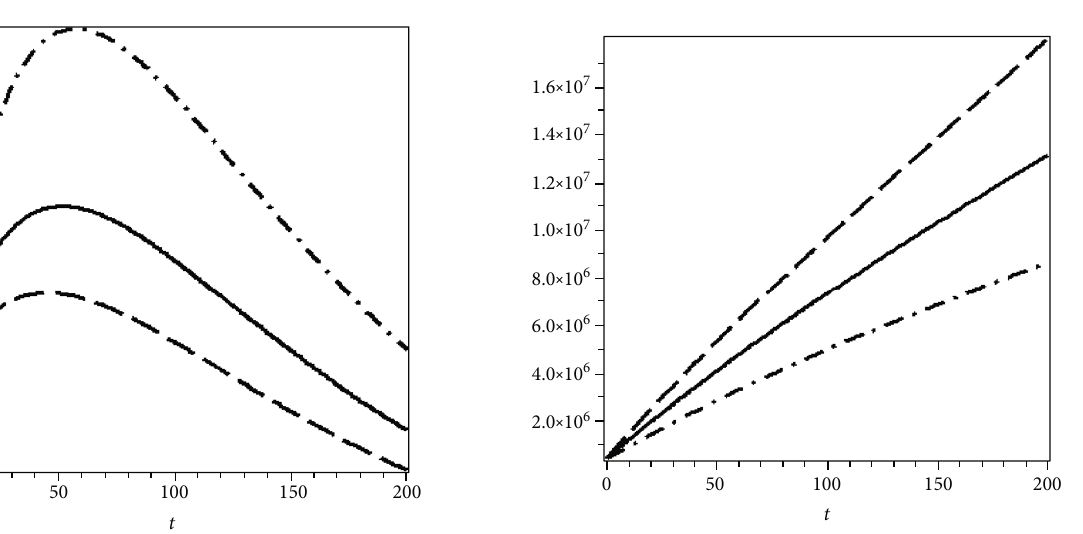
Figure 10: The e ff ect of the reproducing number on the infected individuals (dashed line, R 0 ≤ 0.98, continuous line R 0 ≤ 1.311, and dashed-dotted line R 0 ≤ 1.96.